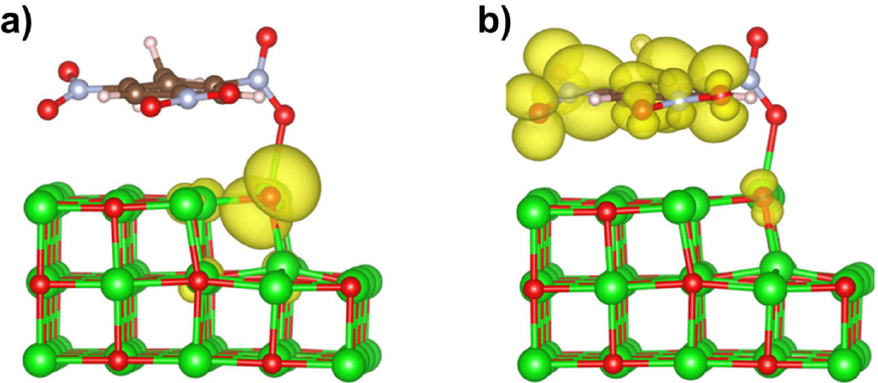
Figure 7. Charge density (shown in three-dimensional yellow contours) for TNT molecule atop a kink at (001) MgO surface (see also Figure 5c) for: ( a ) the highest occupied state; ( b ) the lowest unoccupied state. Mg—in green, O—in red, C—in brown, N—in blue, H—in white.